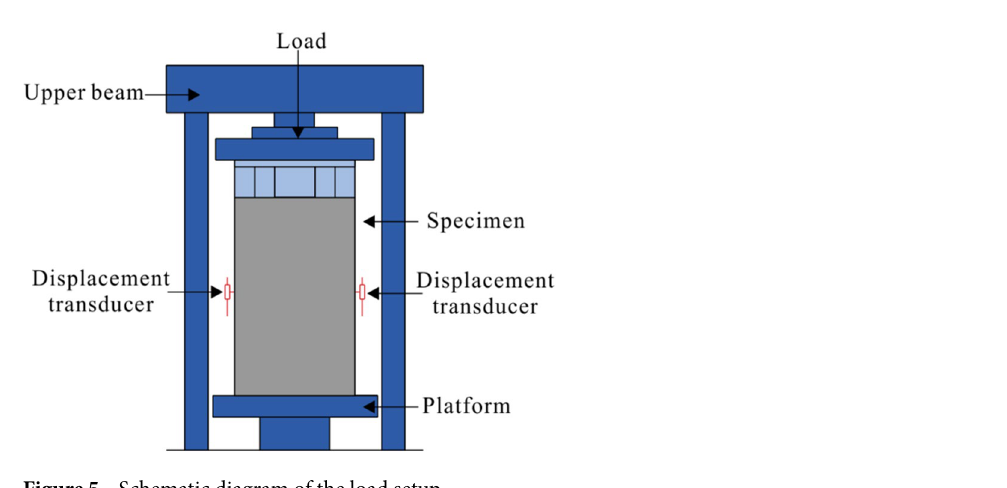
Figure 5. Schematic diagram of the load